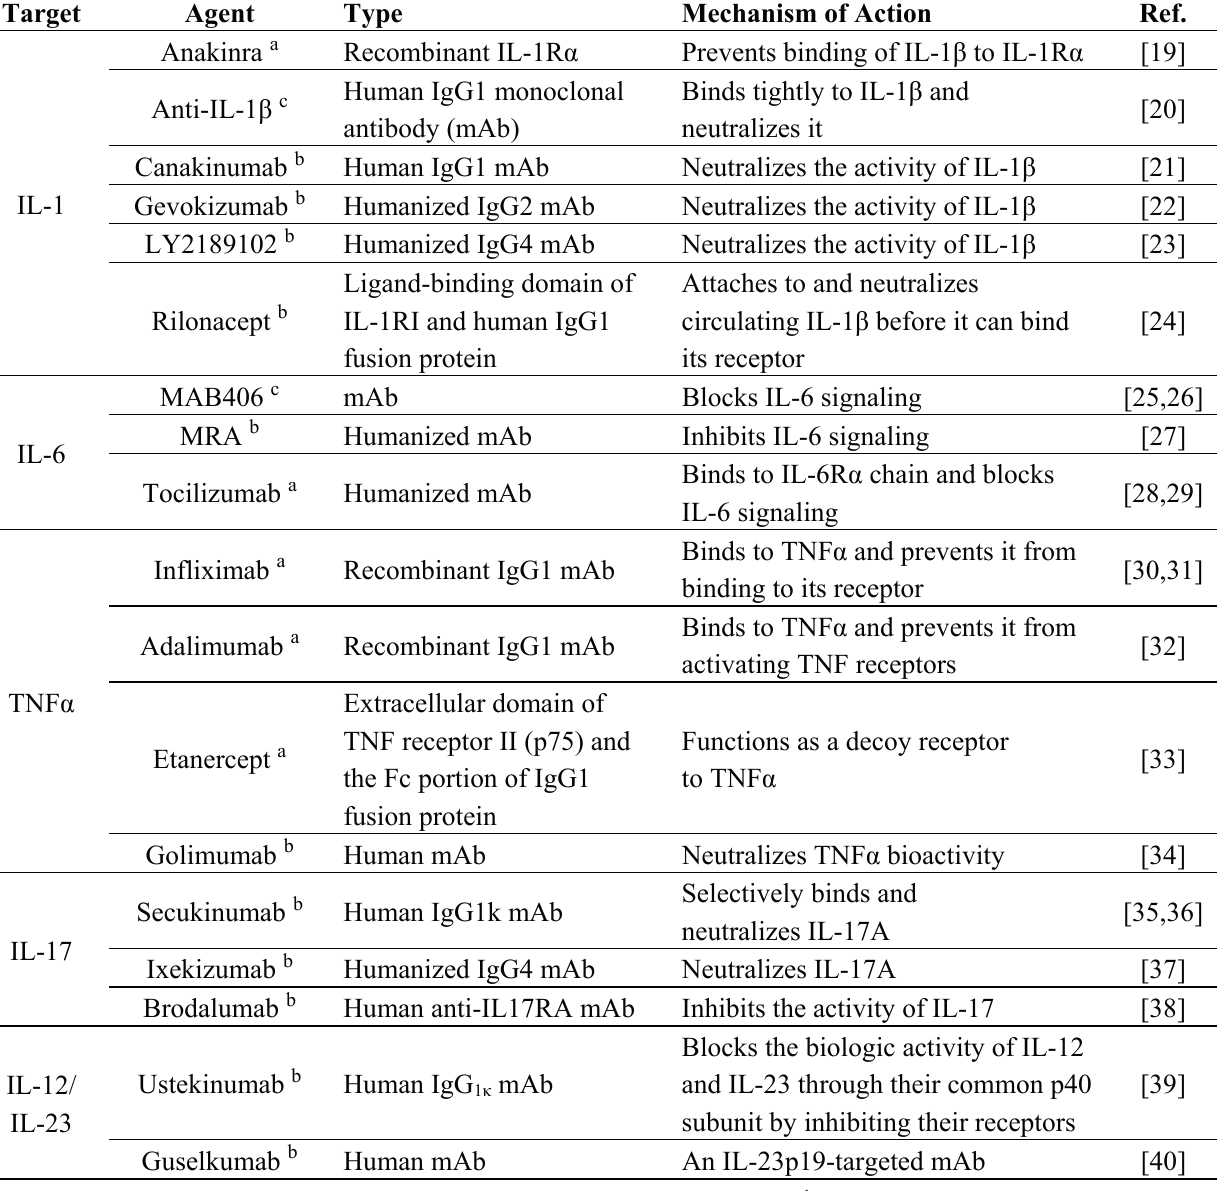
Table 1. Examples of antibodies tested for the treatment of arthritis and other inflammatory/autoimmune